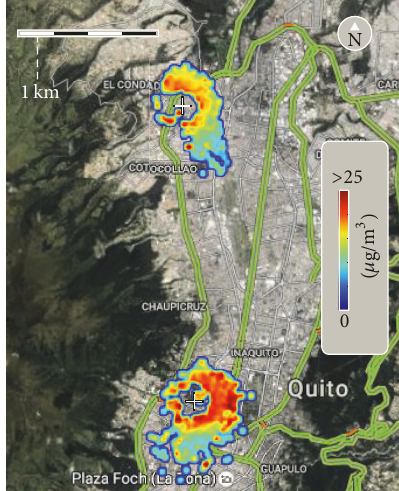
Figure 3: CGM visualization, positioned on top of the geographic location of the respective monitoring stations (northwestern part of Quito). The northern CGM visualization is Cotocollao and the southern one is Belisario. Main highways are represented in green.